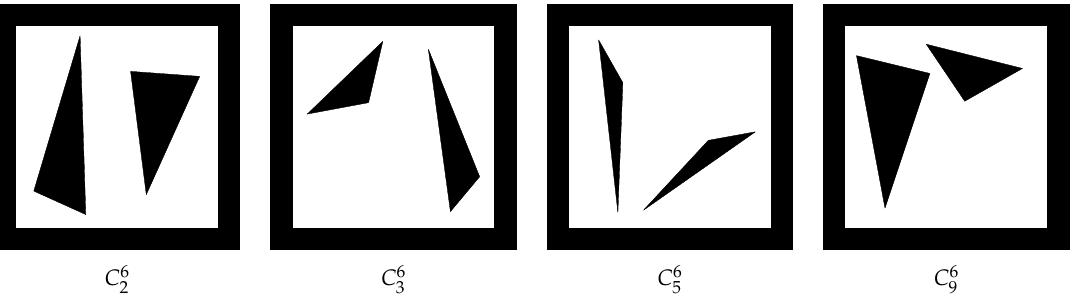
Figure 1. Four examples of order type tags (OTTS). The labels represent the subset number within the set C 6 (it is the set of all possible OTs formed with six points) in the database in [14]. More details about this notation will be given in the following sections of this